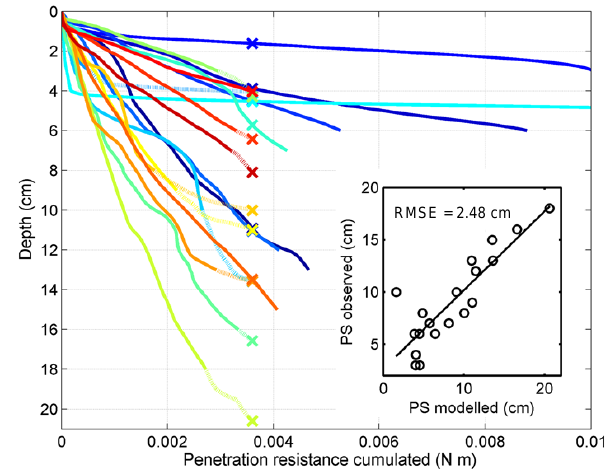
Figure 2. Cumulated penetration resistance ( = dissipated energy) vs. depth for 19 SMP penetration resistance-depth signals. Solid lines show the paths of cumulated penetration resistance up to ob- served penetration depth PS. Crosses denote corresponding depth ( = modeled penetration depth ps) for the average value of dissipated energy e a = 0 . 0036Nm. If observed PS is lower than modeled ps, a dashed line leads from the end of the solid line to the corresponding cross. Inset shows modeled vs. observed penetration